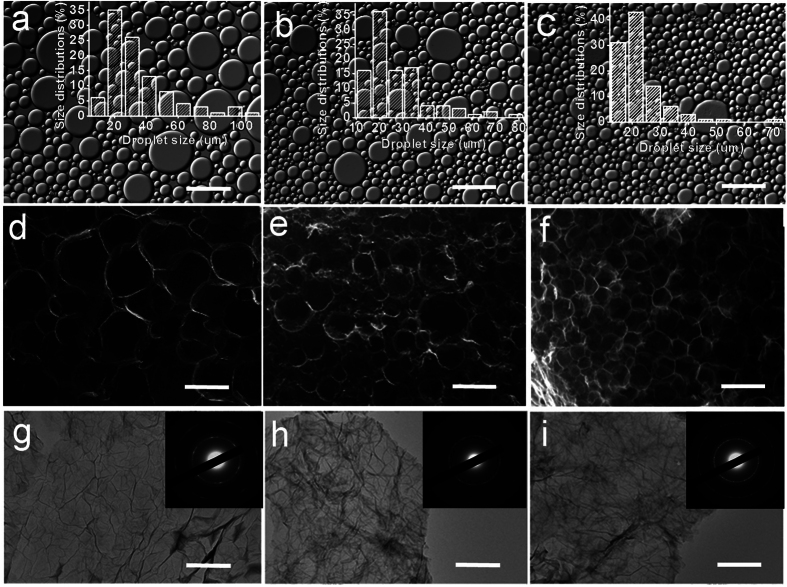
Effect of GO concentration on the microstructures of emulsions and GAs.(a–c) CLSM images of the emulsions with GO concentrations of 0.75 mg mL−1, 1.25 mg mL−1 and 2.00 mg mL−1, respectively. Droplet size distributions of the emulsions are shown in the insets. (d–i) SEM and TEM images of GA-1 (d,g), GA-2 (e,h) and GA-3 (f,i), derived from the emulsions with GO concentrations of 0.75 mg mL−1, 1.25 mg mL−1 and 2.00 mg mL−1, respectively. The macropore sizes of the three GAs are consistent with the droplet sizes of the respective emulsions. The insets in g-i are the electron diffraction of the cell wall, from which it can be deduced that the thickness of the wall increases with the increasing GO concentration. Scale bars, 100 μm in (a–f) and 1 μm in (g–i).